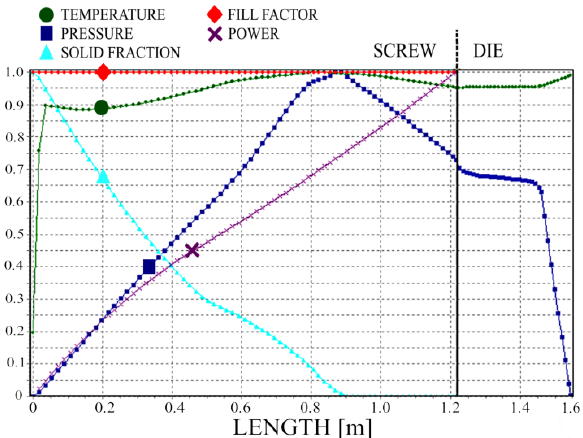
Figure 10. Dimensionless overall extrusion process characteristics, N = 80 rpm.